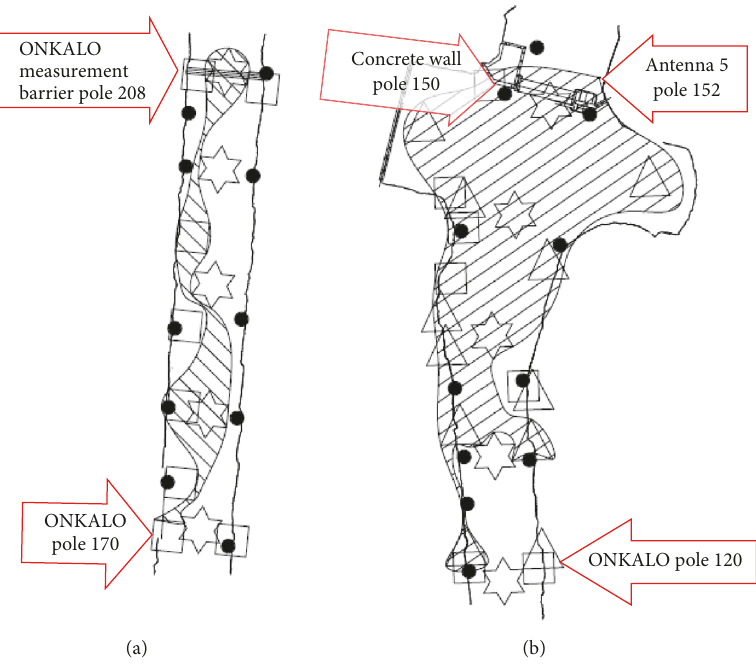
Figure 23: Antenna 5 front reading area (a) and rear reading area